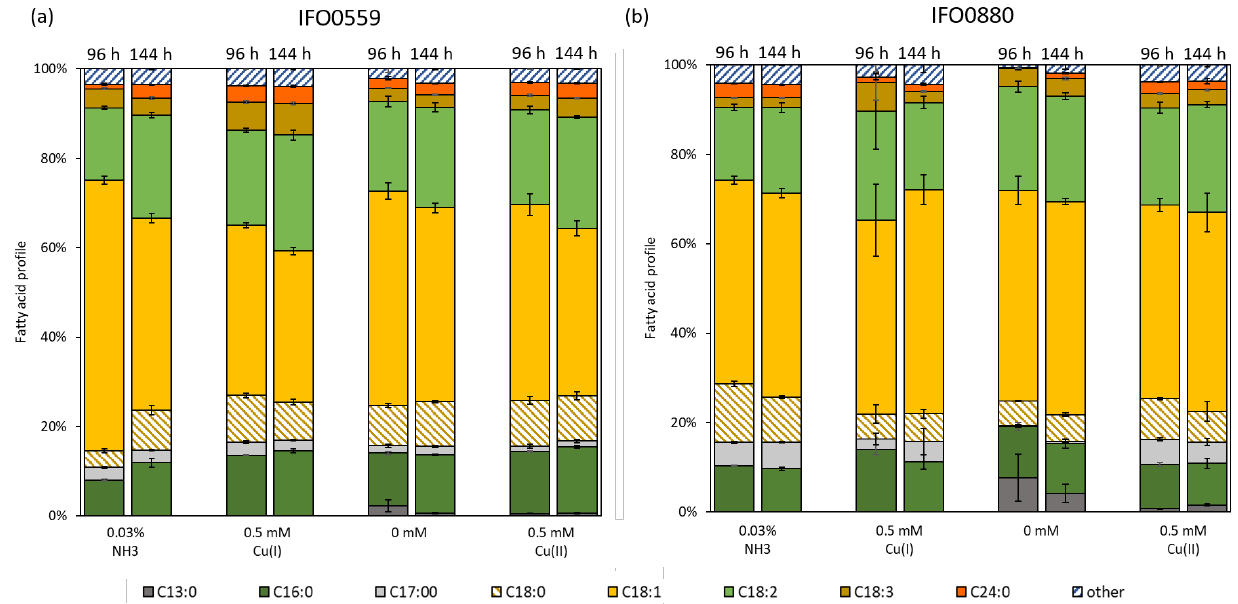
Figure 4. Fatty acid profiles of R. toruloides treated with 0.5 mM Cu(I) and Cu(II) as well as a control, whereas NH 3 served as control to Cu(I)-treated samples and 0 mM served as control to Cu(II)- treated samples (n = 3). “Other” constitutes fatty acids with a representation below 2%, and include s, among others, C14:0, C15:0, C16:1, and C17:1. For each group, the two timepoints 96 h (left) and 144 h (right) are depicted. ( a ) Fatty acid profile of R. toruloides IFO0559 and ( b ) fatty acid profile of R. toruloides